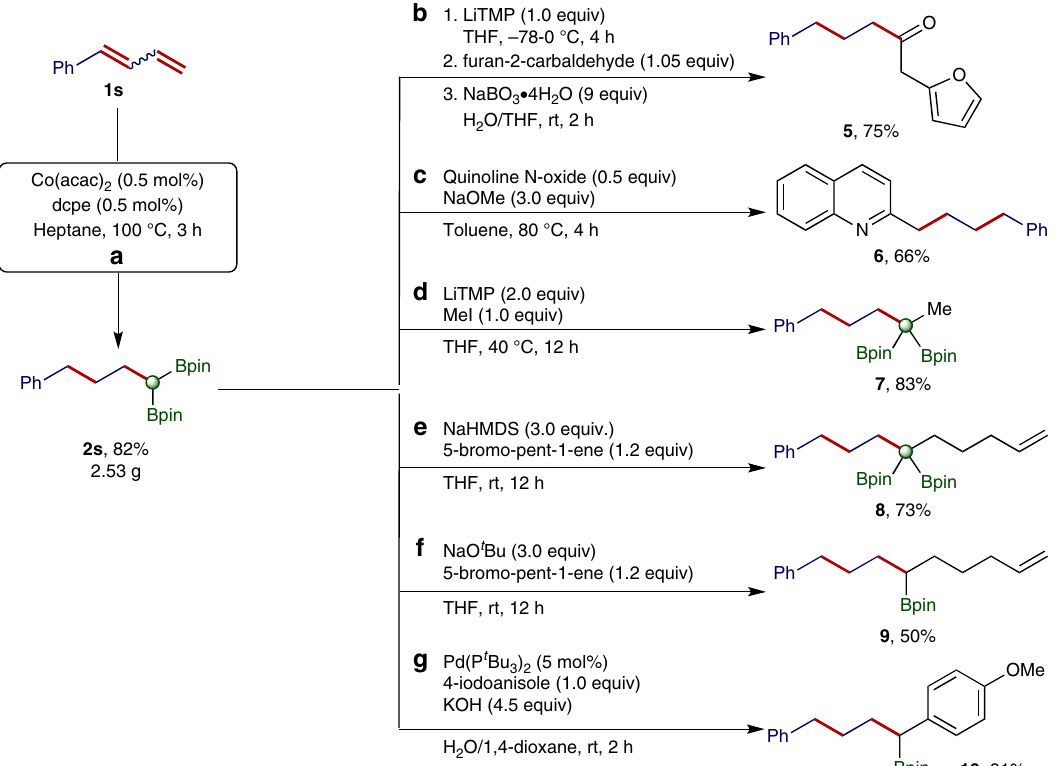
Fig. 5 Gram-scale synthesis of gem -bis(boryl)alkane 2s and its further transformations. a Gram-scale synthesis of 2s . b Synthesis of 5 . c Synthesis of 6 . d Synthesis of 7 . e Synthesis of 8 . f Synthesis of 9 . g Synthesis of 10